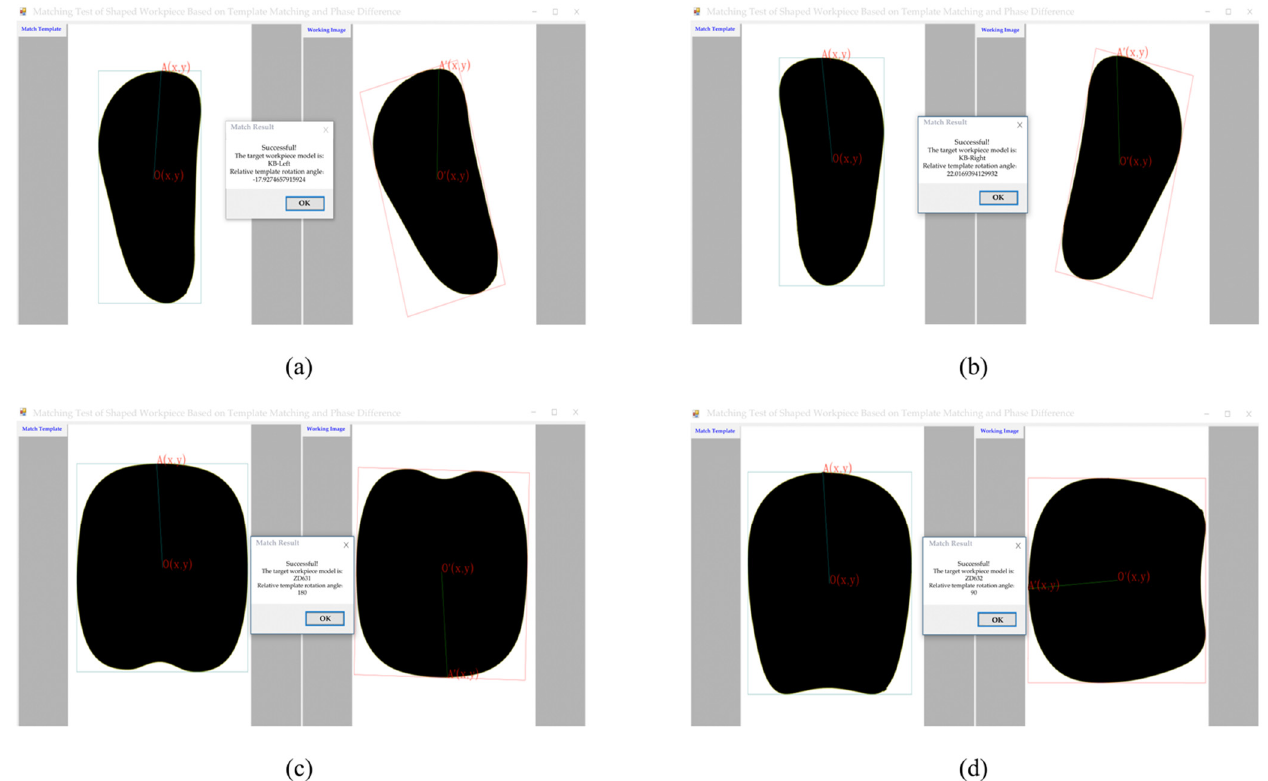
Figure 8. Target workpiece phase difference match. ( a ) −18° Rotation of the KB-Left; ( b ) 22°rotation of the KB-Right; ( c ) 180°rotation of the ZD631; ( d ) 90°rotation of the ZD632.